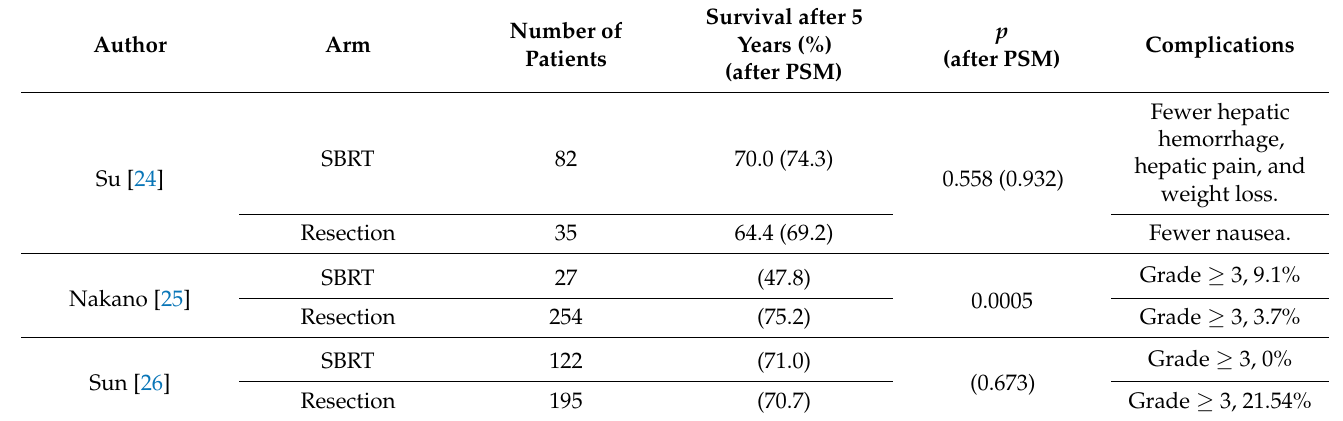
Table 4. SBRT versus hepatectomy: retrospective